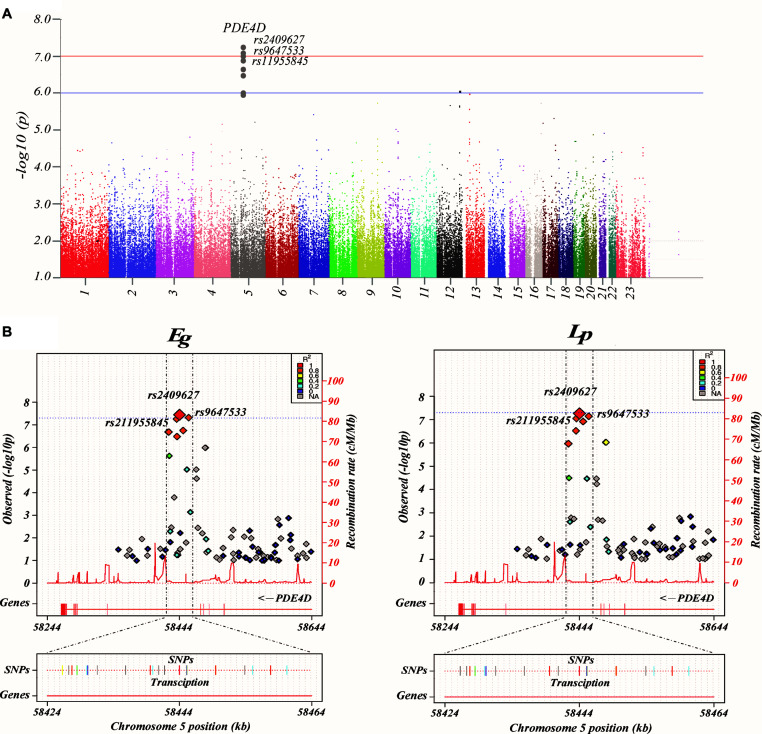
Common genetic variants associated with brain networks. (A) Manhattan plot presentation of the genome-wide association study (GWAS). The parameters examined in this analysis are the brain network properties, which were calculated using MATLAB and adjusted for age, sex, and education. Shown on the left of the Manhattan plot are the p-values [-log10 (observed p-value)] from the GWAS analysis. The horizontal lines display the cutoffs for two significance levels: blue line for p < 10–6 and red line for p < 10–7. (B) Regional association and functional annotation of previously unknown genome-wide significant loci. Regional association plots for the 3 significant loci of the GWAS results on brain network properties (GENCODE version 19). Plots were generated using LocusTrack software (http://gump.qimr.edu.au/general/gabrieC/LocusTrack/).